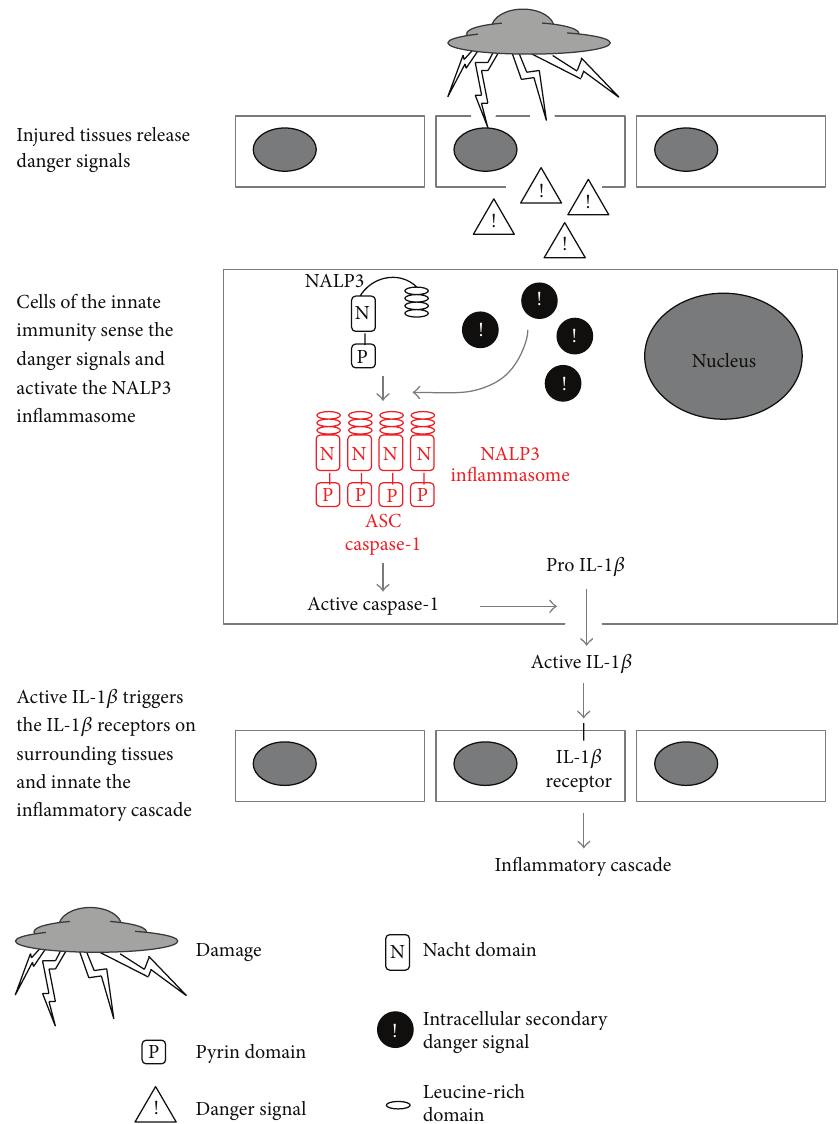
Figure 1: Model of danger signals activation of the NALP3 inflammasome. Tissue injury leads to the formation and release of danger signals such as ATP or uric acid crystals that are recognized by the innate immune system. A number of these signals mediate a potassium efflux or other secondary intracellular danger signals that are required for NALP3 inflammasome activation [51, 52]. NALP3 inflammasome then oligomerizes to recruit the adaptor ASC and caspase-1 [53]. Activation of caspase-1 results in the processing and maturation of pro IL-1 𝛽 into its biologically active form, active IL-1 𝛽 [12, 54]. Active IL-1 𝛽 will then trigger the IL-1 𝛽 receptor, leading to the activation of multiple cytokines involved in the inflammation cascade [55].